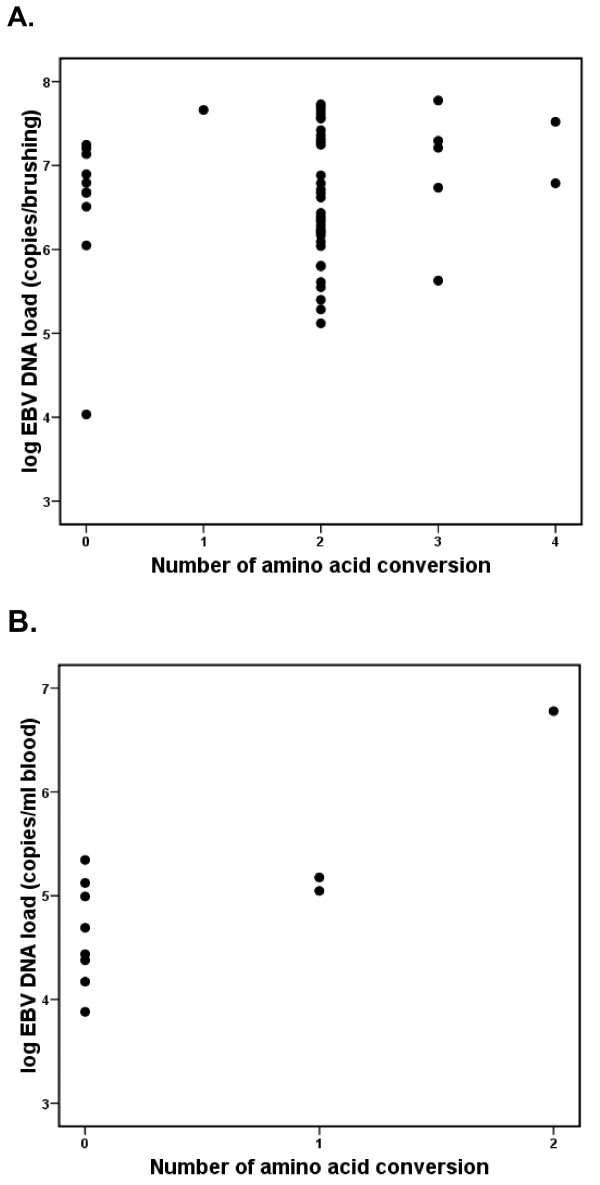
Scatter diagram of EBV DNA load in 53 NPC brushing samples (copies/brushings) (A) and 11 non-NPC other EBV-associated isolates (copies/ml) (B) versus BARF1 amino acid conversion. The Y axis was expressed in a log scale with cutoff value set on 2,300 copies/brushing in NPC brushing and 2,000 copies/ml in other EBV-related isolates as defined before [10]. In NPC group EBV DNA load did not relate to the presence of amino acid conversion while in other EBV-associated diseases it did (one-way ANOVA p = 0.606 and 0.014 respectively).